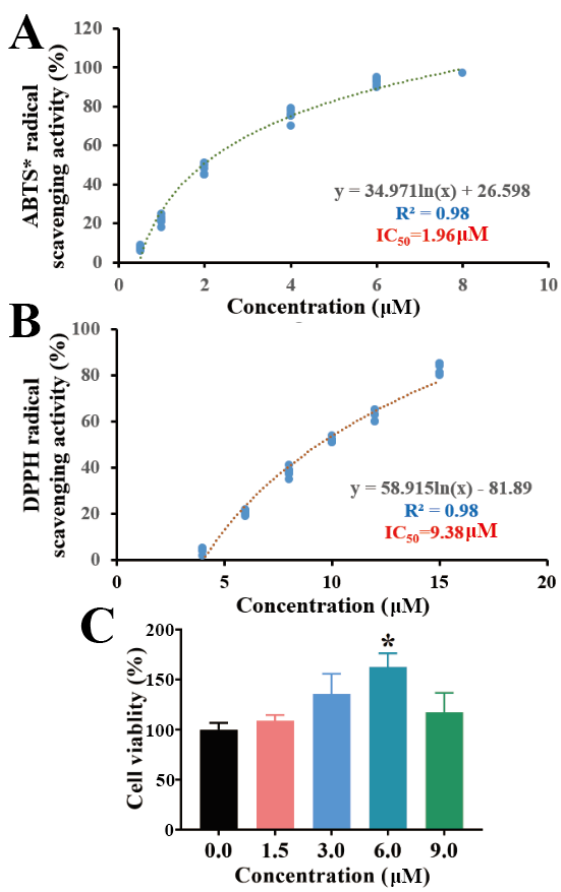
Figure 3. In vitro antioxidant capacity and cytotoxicity of Torularhodin. ( A ) Effect of Torularhodin on the in vitro antioxidant activity of ABTS. ( B ) Effect of Torularhodin on the in vitro antioxidant activity of DPPH. ( C ) Effect of Torularhodin on the cytotoxicity of RAW 264.7. Logarithmic equation in logistic regression was used in regression equation. * p < 0.05 indicated statistical significance compared with “0.0” group.